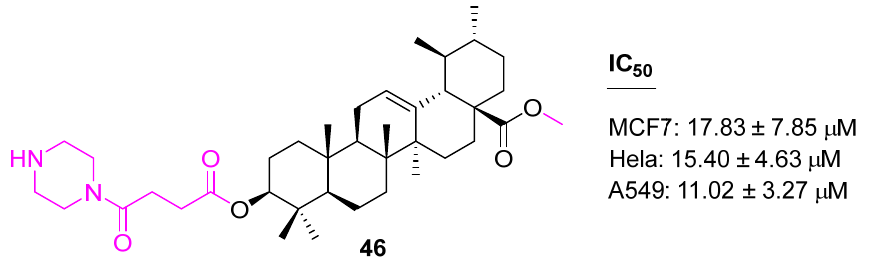
Figure 31. Structure of 46 .